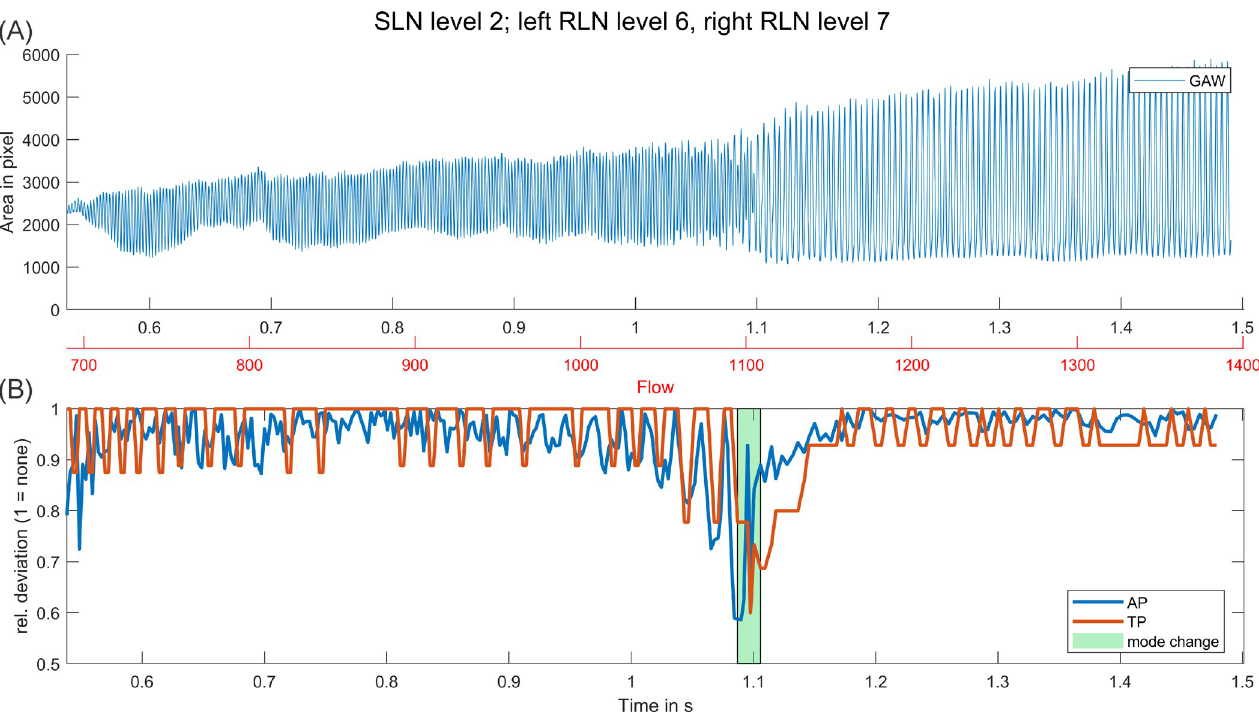
Fig 5. Perturbation before and during a mode change. (A) GAW over period of stimulation with increasing flow. (B) AP and TP over same period with marked mode change at 1.1